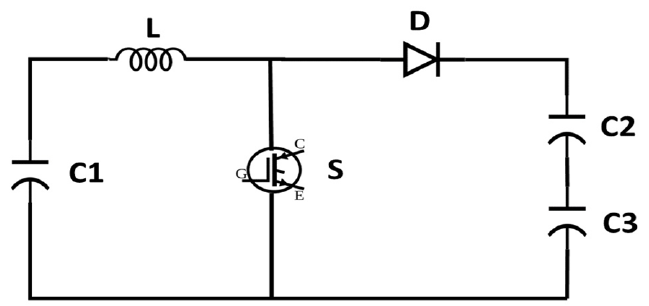
Figure 4. The used boost converter circuit.